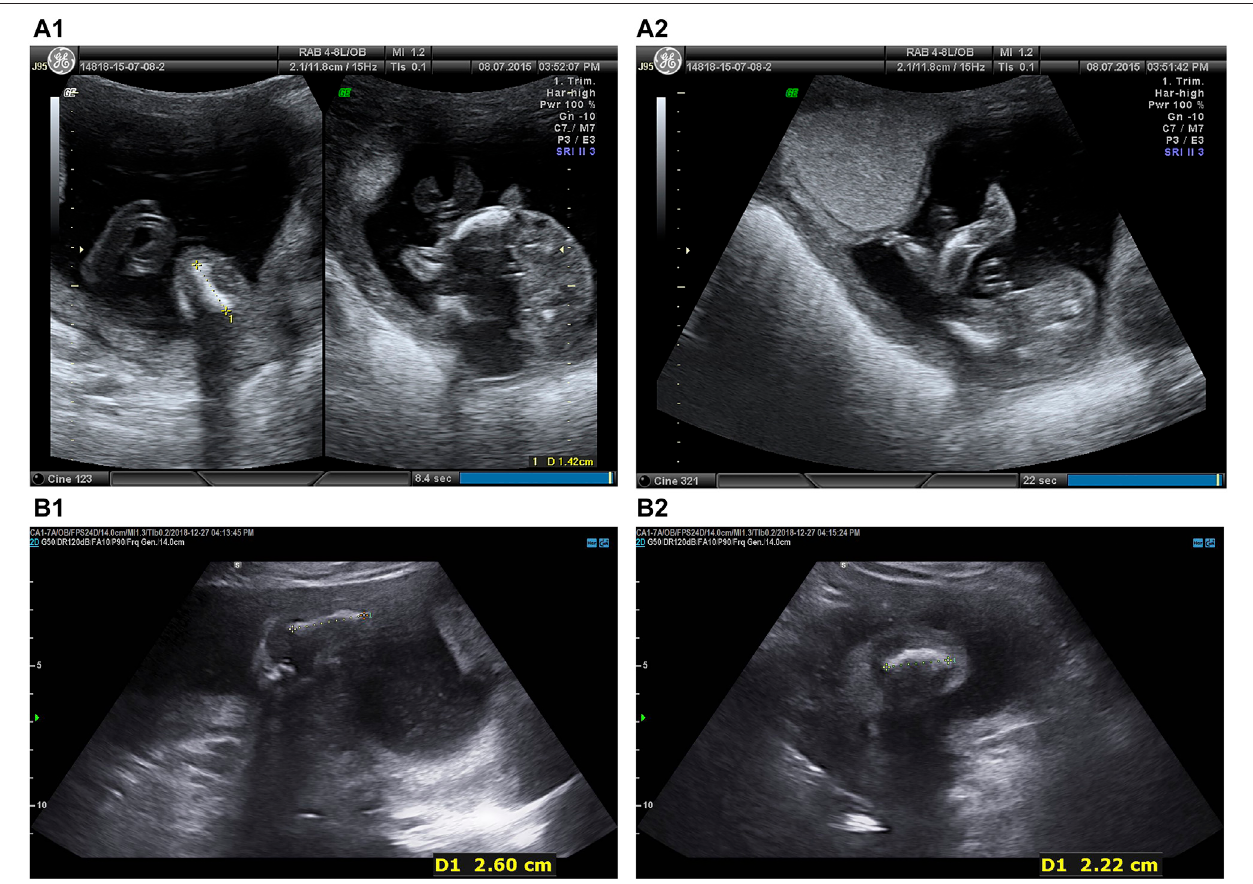
FIGURE 2 | Prenatal ultrasonic examinations of the two fetuses in the second trimester showed bowed extremities (A) Intrauterine fetal ultrasonic examination of the fi rst pregnancy at 18 + 5 weeks in 2015: navel, oval skull ring, double top diameter of 4.0 cm, lateral ventricle cerebellar hemisphere form with no obvious abnormalities, bowed lower extremities, bowed femur (1.4 cm), bowed tibia and fi bula (1.4 cm), bilateral humerus (1.8 cm), radius (1.6 cm), bowed ulna (1.7 cm), crossroads of fetal heart breaks (0.2 cm), (A1 left) Femur. (A1) Tibia. (A2) Fibula. (B) Intrauterine fetal ultrasonic examination of the third pregnancy at 24 + 2 weeks in2018:navel, ovalskullring,doubletop diameterof5.6cm, midlineheadcircumference(20.4 cm) inthemiddleandlateral ventriclecerebellar hemisphereformwithno obviousabnormalities,bowedupperandlowerextremities,fetalbilateralbowedfemur(1.8 cm),bowedtibiaand fi bula(1.9 cm),bowedhumerus(2.6 cm),bowedradius